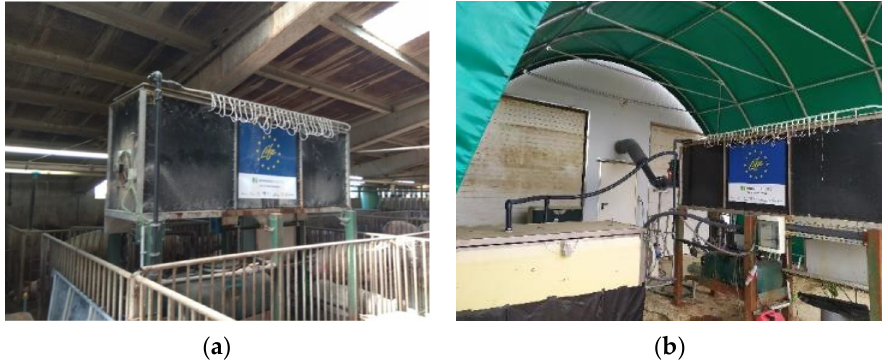
Figure 1. Location of the prototype: ( a ) inside the gestating sow house, ( b ) connected outside the free-range laying hen farm.